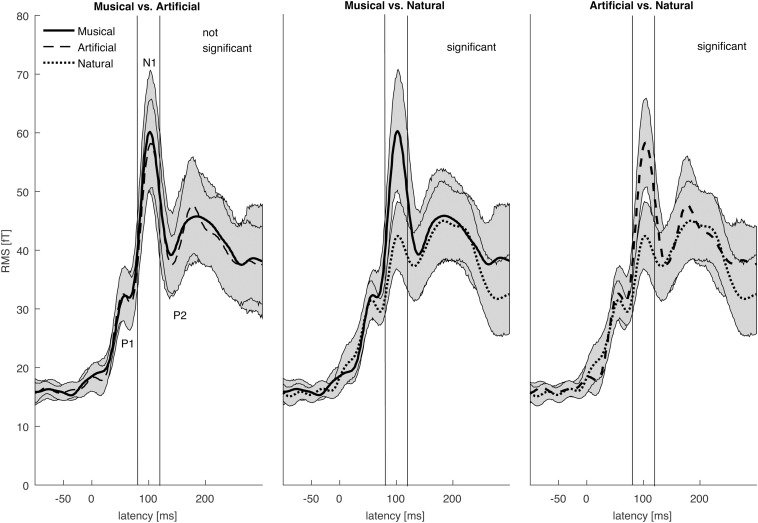
The root mean square of the grand averages of the auditory evoked field (AEF) for the Musical, Artificial, and Natural sounds. The graphs illustrate the brain activation within the time domain (–100 pre-stimulus onset to 300 ms post-stimulus) with 0 ms representing the stimulus onset. The AEF components P1, N1, and P2 as well the time interval 80–120 ms are labeled. The means of the different types of sounds are marked with different types of lines. Their corresponding 95% confidence intervals are given by shaded areas. The time interval of interest is around the N1 component of the auditory evoked field (80–120 ms).